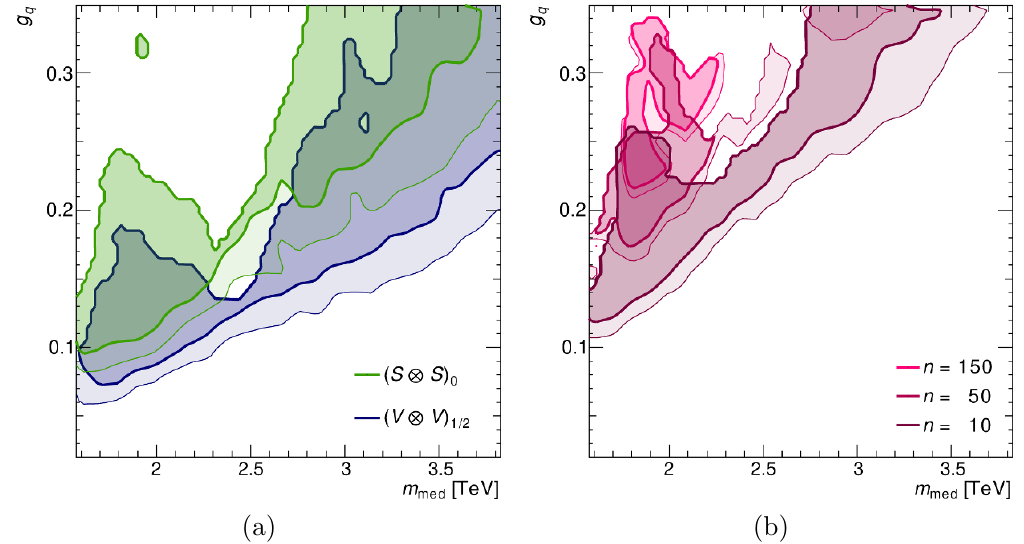
Figure 3 . The left panel (a) is the same as (cid:12)gure 2, but now focusing on the models ( S (cid:10) S ) and ( V (cid:10) V ) . Both models generate ^ O 1 as a leading non-relativistic operator for DM-nucleon 1 = 2 interactions. The thick (thin) outline corresponds to a 5 (cid:27) (3 (cid:27) ) discovery. Discovery contours are partly non overlapping. In the right panel (b) we show how the regions where dijets searches could make a discovery in the ( S (cid:10) PS ) model if instead of n = 150 only n = 50 or n = 10 events 1 = 2 would be observed at